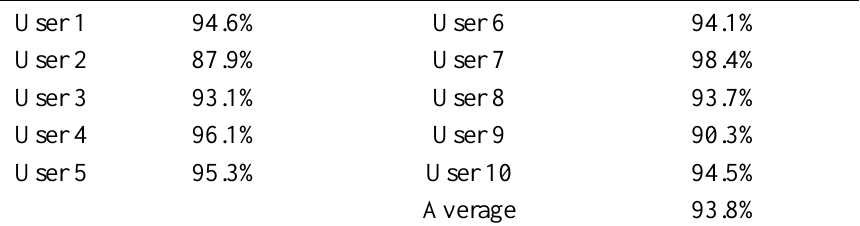
Table 4. Decision Tree leave-one-user-out overall accuracy